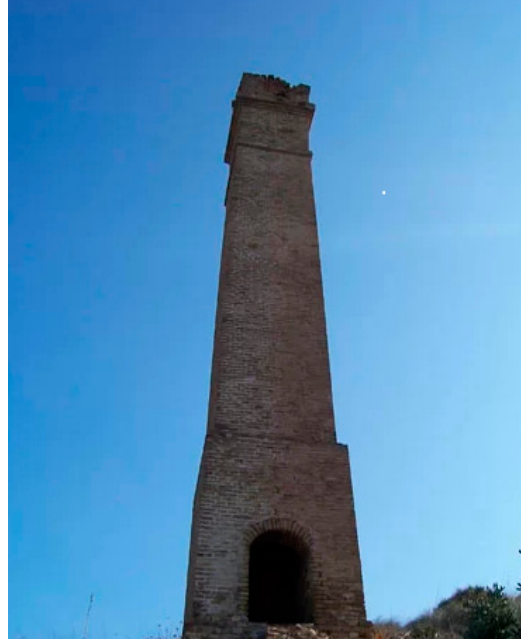
Figure 4. Chimney. Municipality of La Unión. Source: Sierra Minera Foundation [31].